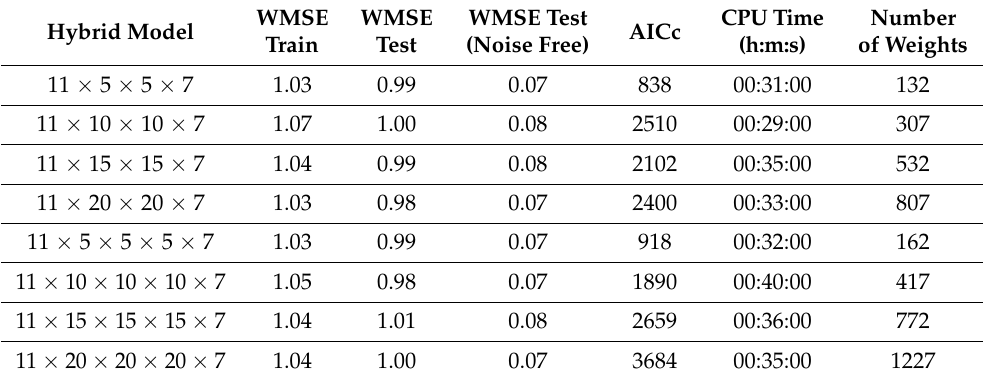
Table 2. Training metrics of different hybrid models for the E. coli threonine synthesis pathway case study (chassagnole1). The dataset was divided in four experiments for training (400 training examples for each state variable) and five for testing (500 testing examples for each state variable). The training was performed with ADAM with default hyperparameters as suggested by Kingma (2014) ( α = 0.001, = 0.9, = 0.999 and ζ = 1 × 10 − 8 ). The number of iterations was 5000. The minibatch size was 78% and weight dropout probability was 0.22 as suggested by Pinto et al. (2022). The AICc was computed on the training set only. The noise-free WSSE measures the error between noise-free data (e.g., true process behavior) and model